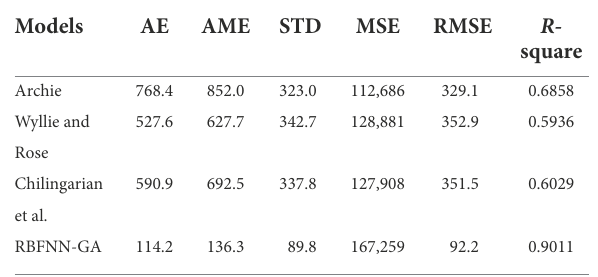
TABLE 3 Determining the static error parameters for predicting k for the total